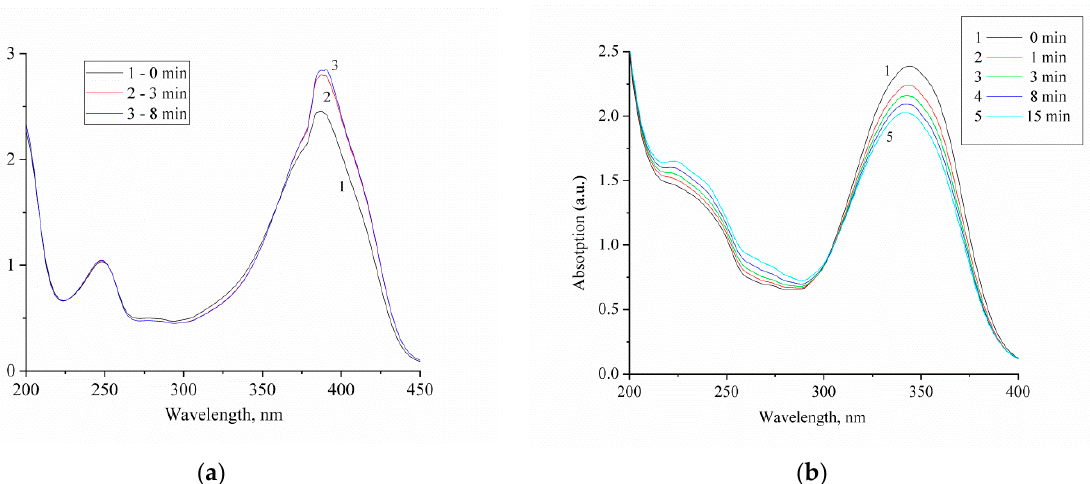
Figure 7. Absorption spectra of compounds 1 ( a ) and 2 ( b ) measured upon UV irradiation at various times as indicated in the insets. The concentration of compounds 1 and 2 was 5 × 10 –5 mol/L.